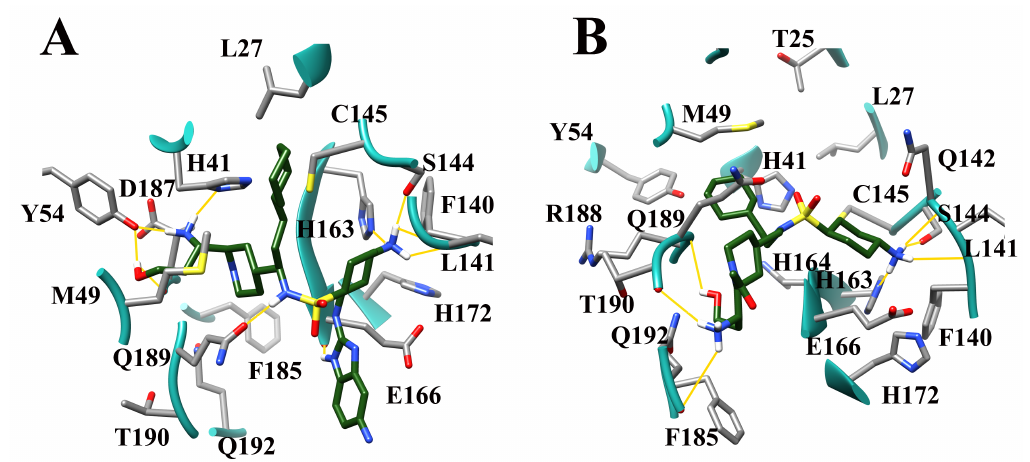
Figure 16. Mode of binding of the top two optimized compounds ( A ) FL30 (green); and ( B ) FL20 (green) designed using molecular guidelines discovered to maximize binding to the SARS-CoV-2 M pro active